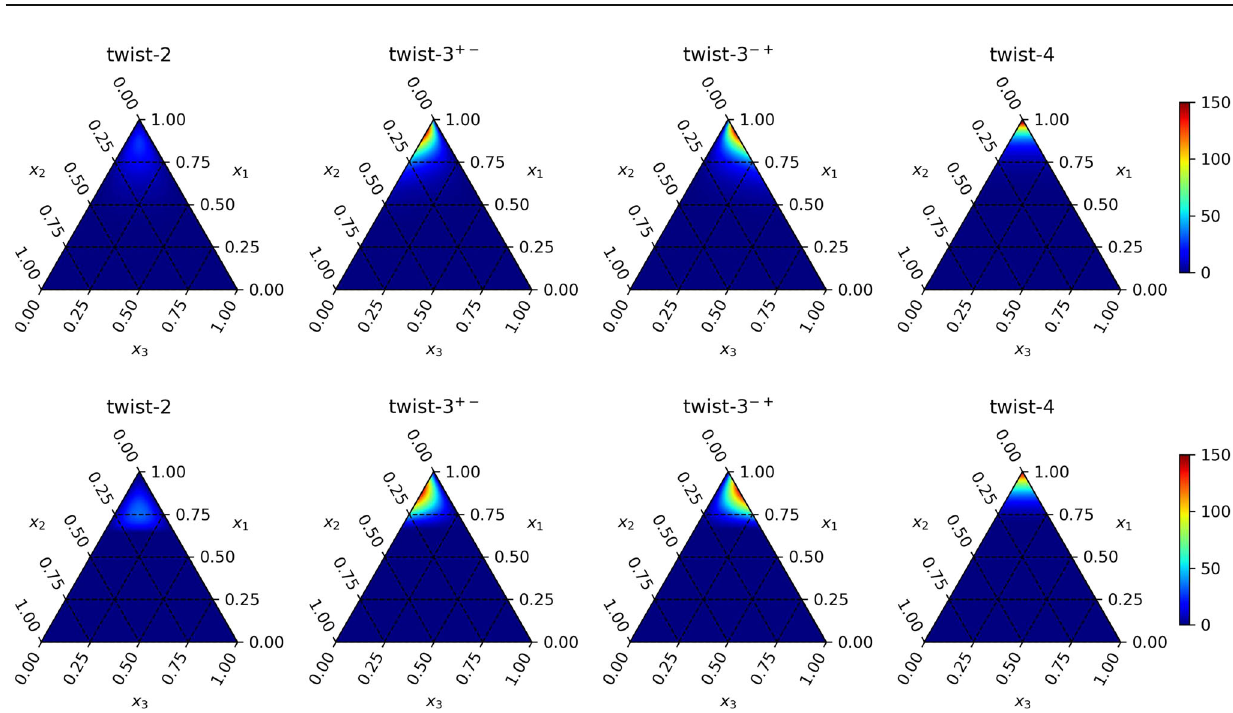
Fig. 2 Dependencies of the (cid:2) b baryon LCDAs ψ 2 , ψ +− free-parton model (bottom) proposed in [67]. Each point inside the triangles satisfies the relation x 1 + x 2 + x 3 =